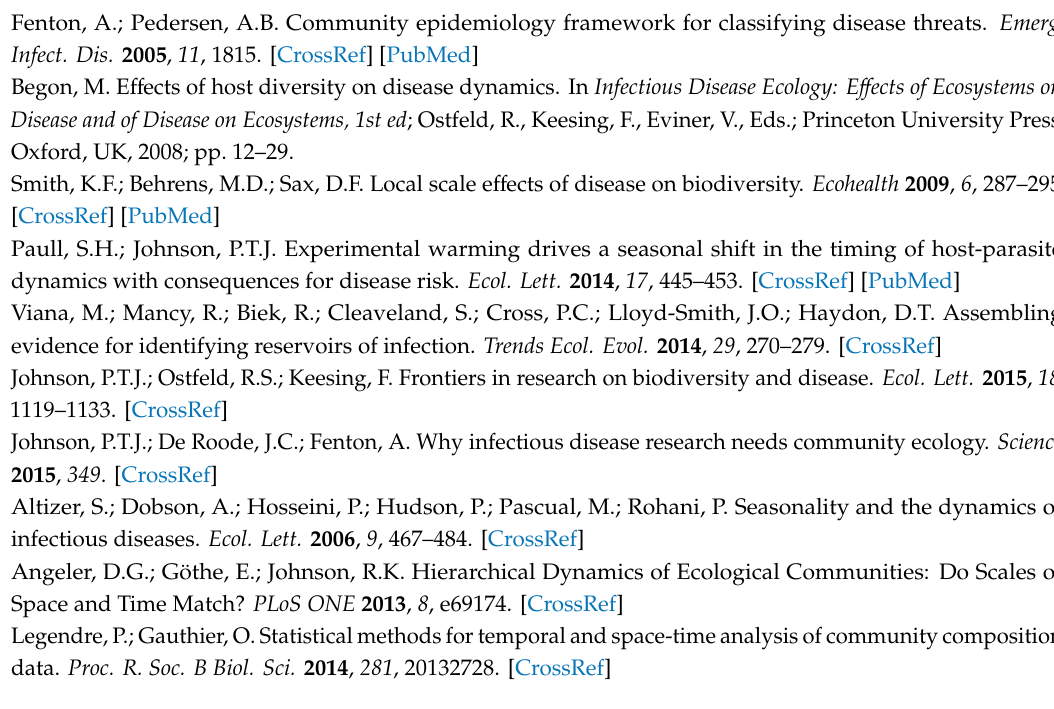
Figure S1.1: Map of the study area and light traps distribution in Gadsden County, Florida; Figure S1.2: Culicoides composition time autocorrelation by multivariate Mantel’s correlogram; Figure S1.3: Environmental constraints on Culicoides β -diversity temporal profiles; Figure S1.4: Culicoides season occurrence in the two modules derived from the weekly co-occurrence network; Figure S1.5: Daily temperature between December 20th and April sampling coverage: sample completeness curve. Supplementary File 2: Culicoides β -diversity